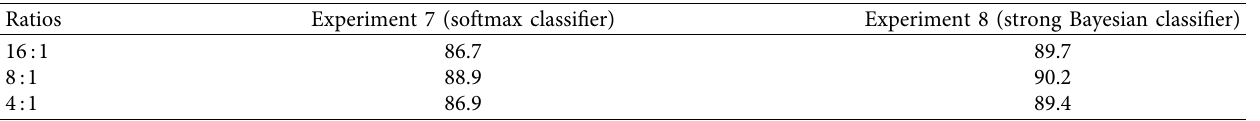
Table 4: Accuracies of 3D model classification at different ratios.